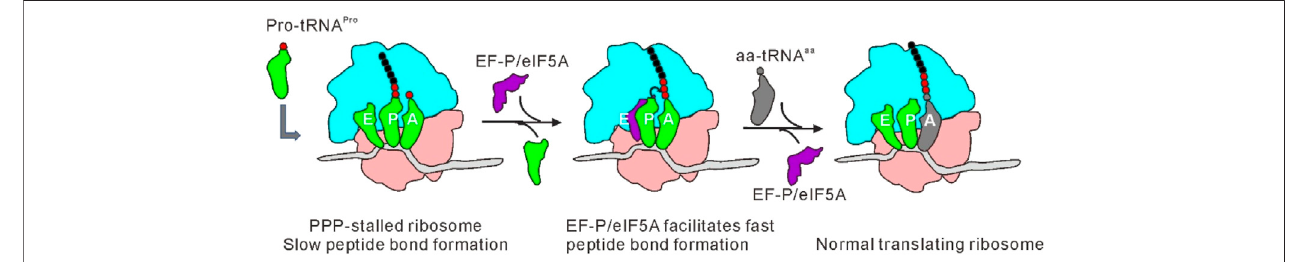
FIGURE6| MechanismofEF-P/eIF5Ainalleviatingribosomestallingatpolyprolinestretches.AccomodationofthethirdconsecutivePro-tRNA Pro intotheA-siteof translating ribosome leads to stalling. EF-P/eIF5A binds to a location between E- and P-sites of the stalled ribosome after E-site tRNA is dissociated, stimulating rapid proline-proline peptide bond formation. Translation can resume following dissociation of EF-P/eIF5A and binding of the next